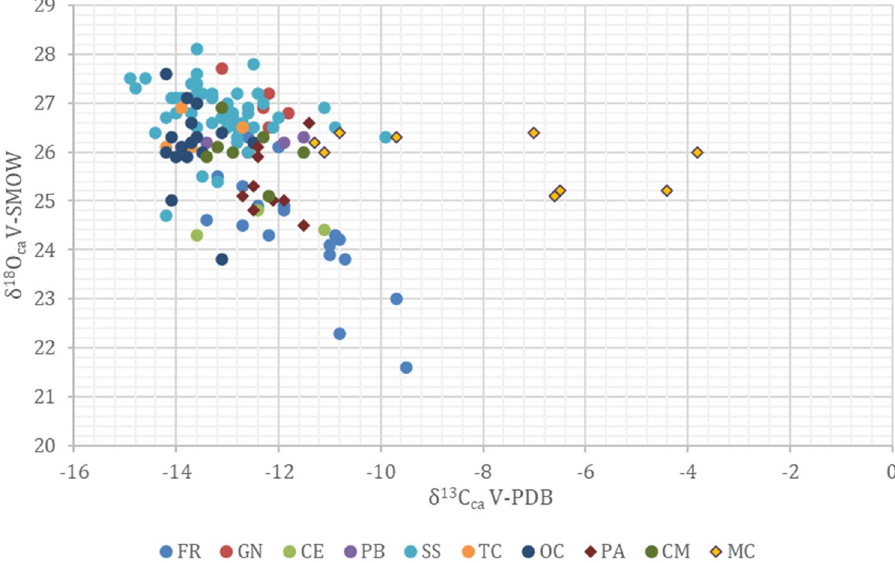
Figure 1. Bivariate plot of oxygen and carbon isotope values for the studied individuals. Samples coming from different locations are indicated with symbols of different colors. Different periods are reported with different symbol shapes: Dots = Copper Age individuals, Rhombus = Neolithic individuals. SS = Buca di Spaccasasso; FR = Fontenoce di Recanati; CM = Casetta Mistici, OC = Osteria del Curato-Via Cinquefrondi; TC = Torre